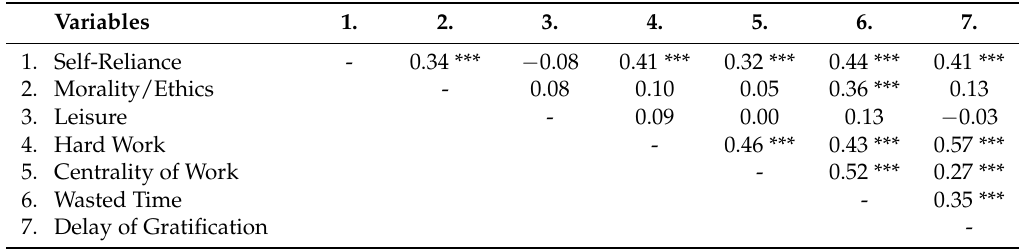
Table 2. Correlations among Work Ethics Measures.